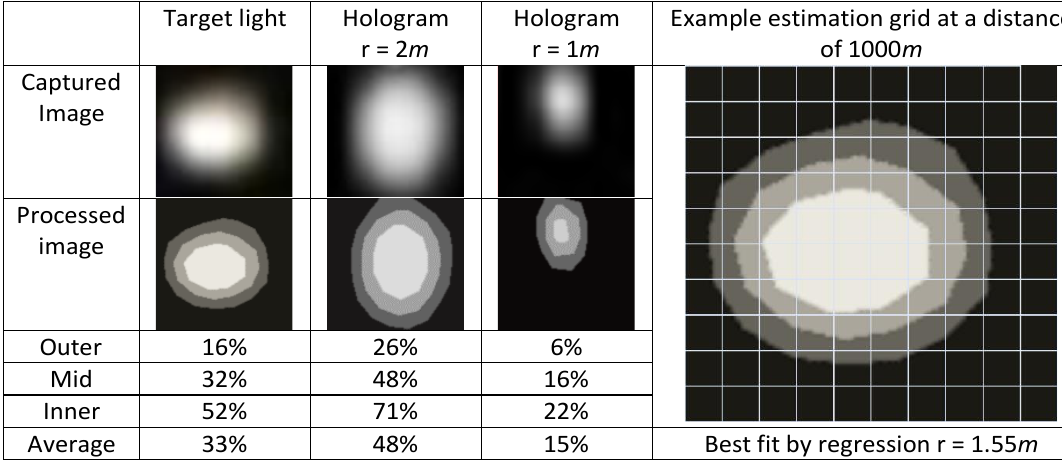
Figure 9. Example of identified best holographic spheres to represent navigation light in the real-world environment.